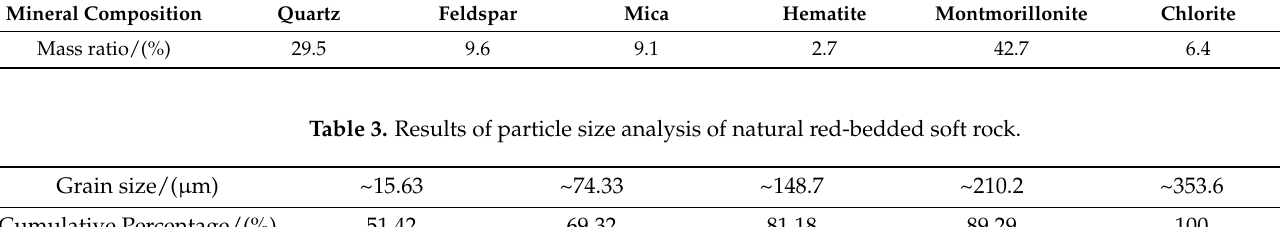
Figure 1. Natural red-bedded soft rock photos from SEM.